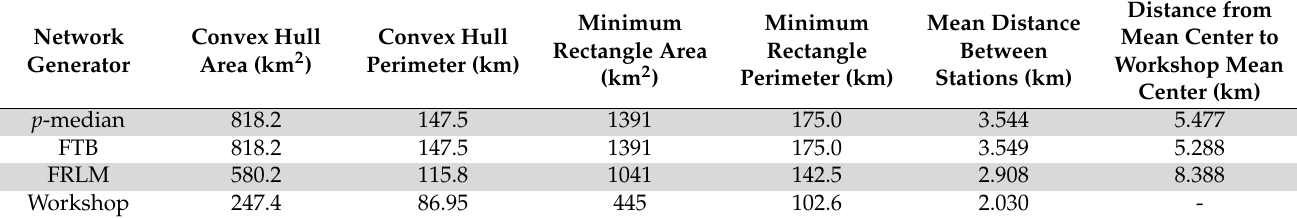
Table 10. Point pattern analysis metrics for 5 stations ( p = 5).